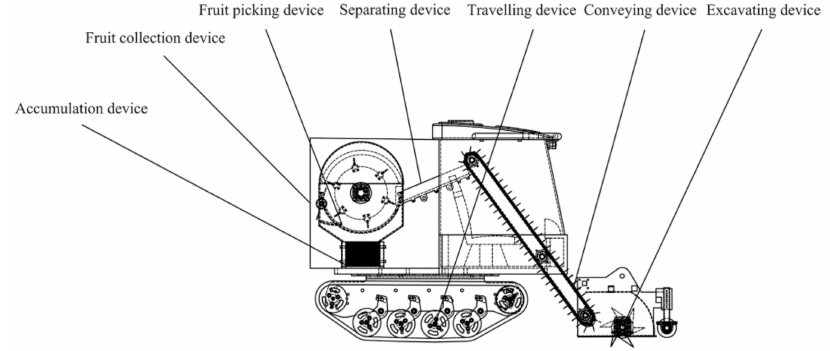
Figure 1. Overall structure of the Cyperus esculentus combine harvester. In the process of Cyperus esculentus harvesting, the counter-rotation device sequentially performs the harvesting of the Cyperus esculentus from the tilled area to the uncultivated area. The Cyperus esculentus agglomerates are broken under the action of the counter- rotating blade, and are thrown from bottom to top along the tangential line of the counter- rotating cover plate, realizing the orderly transition between the excavating device and the conveying device. Under the action of the scraper-conveying device, the orderly conveying of the Cyperus esculentus agglomerates is realized; under the action of the fruit-picking device, the separation of the root system, the tuber and the soil is realized; and under the action of the cleaning device, the Cyperus esculentus tuber and impurities are